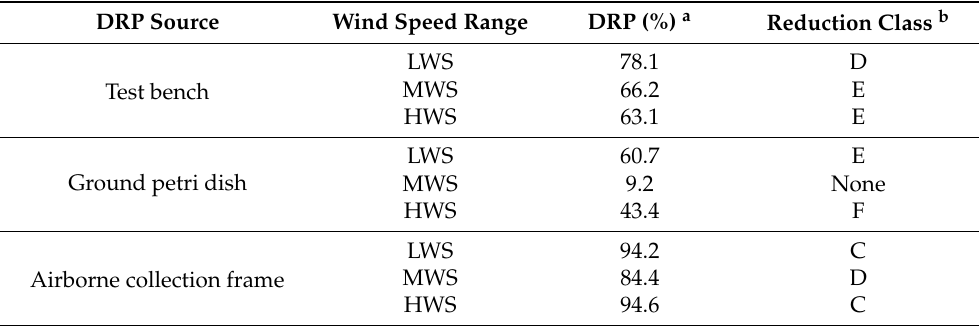
Table 5. Drift reduction percentage and classification when using the AI nozzle based on test bench, ground petri dish and airborne collection frame for the tested wind speed